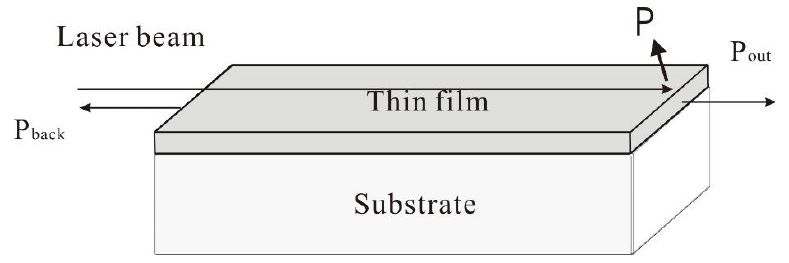
Figure 16. Schematic of the back-reflection method.